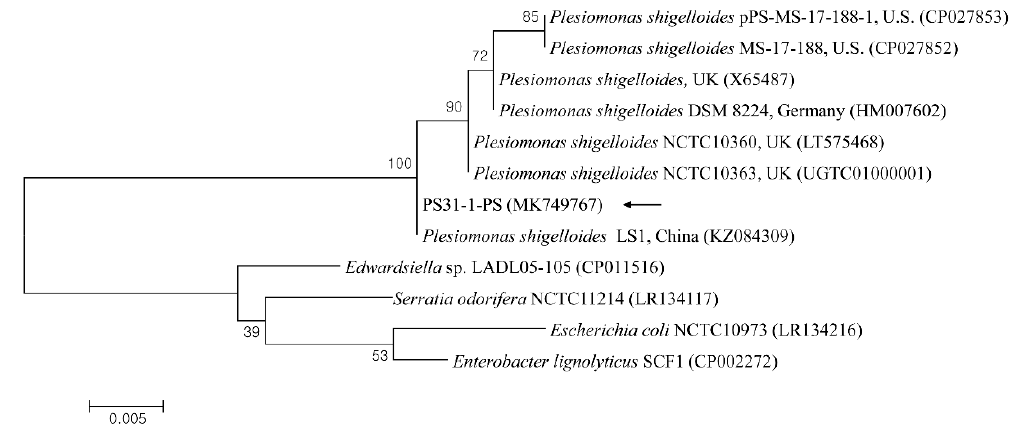
Figure 3. Phylogenetic tree constructed using the maximum likelihood method based on 23S rRNA nucleotide sequences of Plesiomonas shigelloides . The black arrow indicates the sequence analyzed in this study. The GenBank accession numbers of other sequences are shown with sequence names. The branch numbers indicate bootstrap support (1000 replicates). The scale bar indicates the phylogenetic distance.